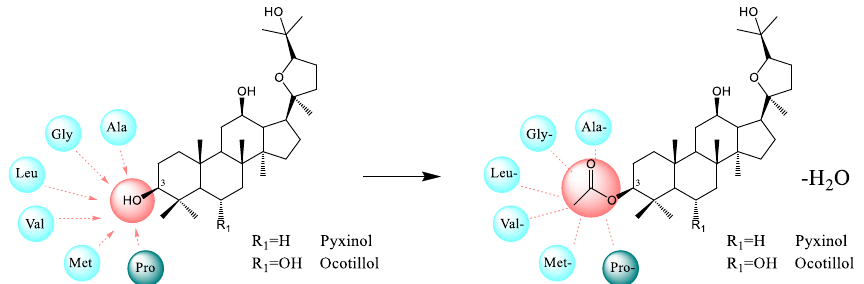
Figure 1. Design of amino acid derivatives of ocotillol-type sapogenins.